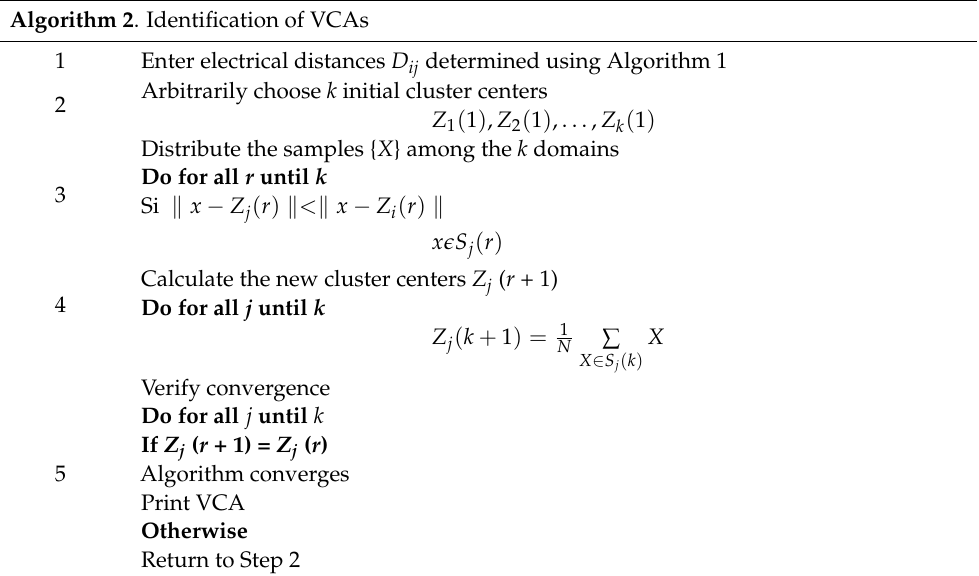
Algorithm 2 . Identification of